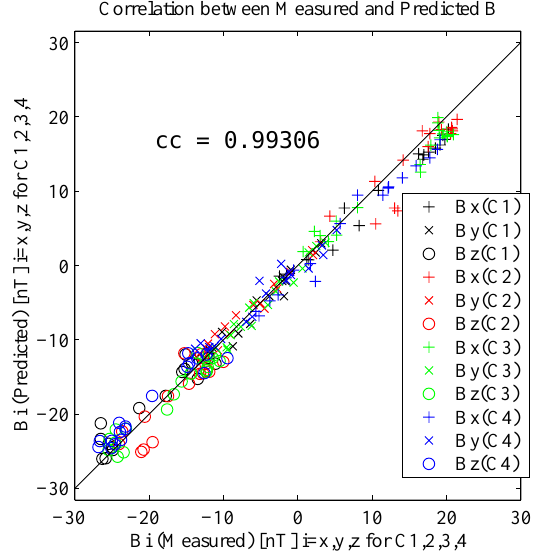
Fig. 6. Scatter plot of three components of the measured versus the predicted magnetic field in the reconstruction coordinates.